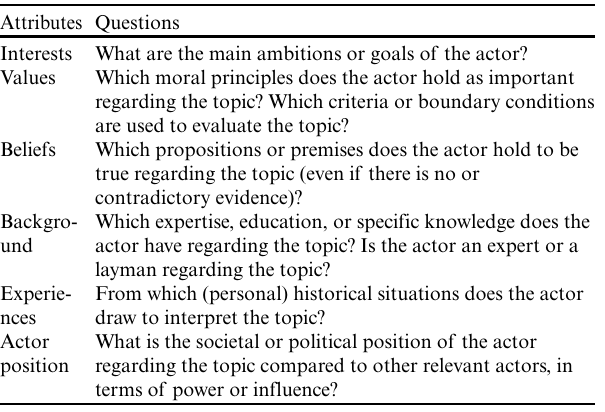
Table 1 . Questions posed to identify actor attributes regarding a specific discussion topic.